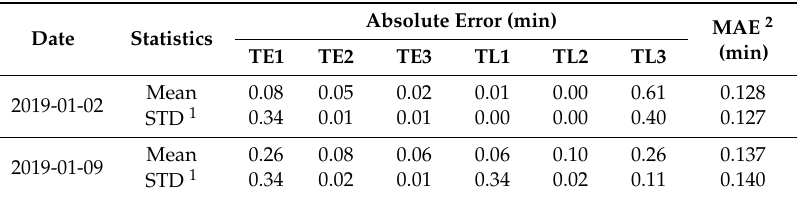
Table 7. Results of absolute error for truck travel times derived from simulation results and the haulage operation performed on January 2 and 9, 2019.